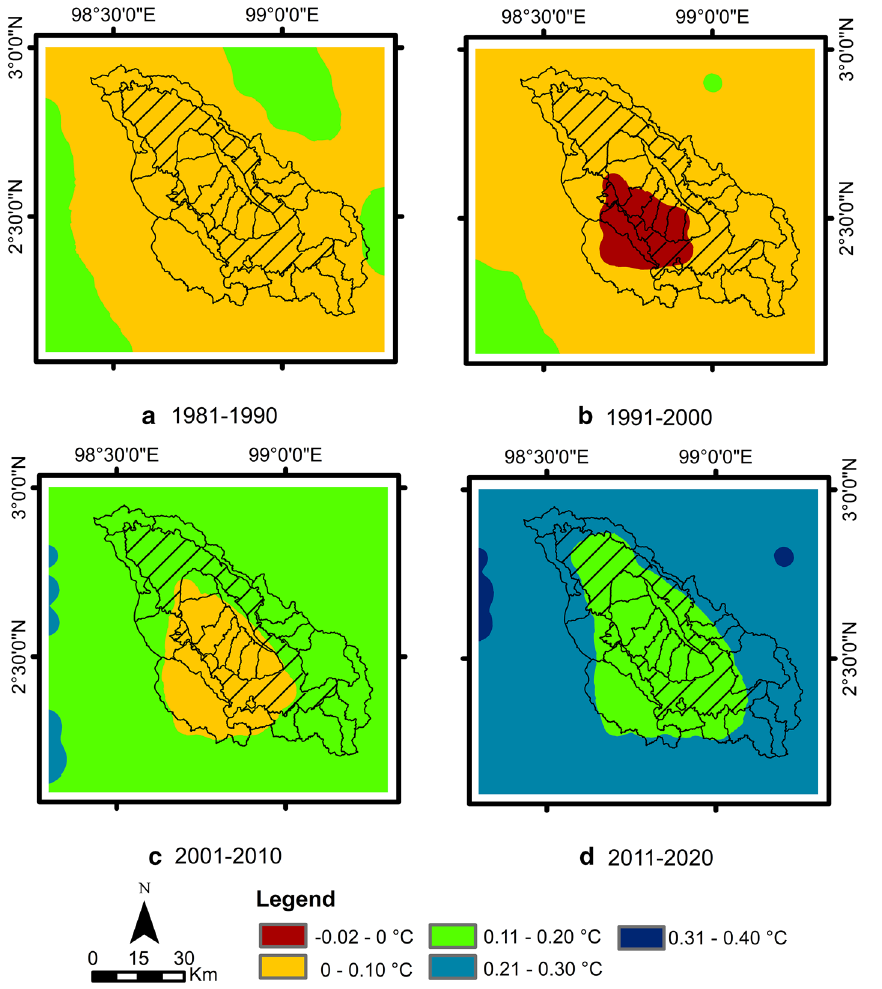
Figure 5. Spatial distribution of temperature changes in the decades ( a ) 1981–1990, ( b ) 1991–2000, ( c ) 2001–2010 and ( d ) 2011–2020 relative to the base period of